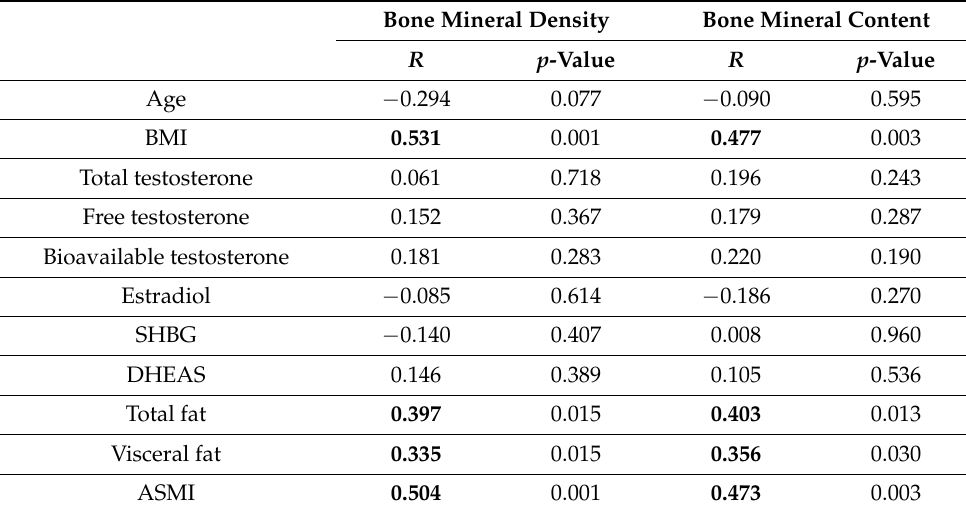
Table 4. Correlations of BMD and BMC with age, BMI, sex hormones, ASMI, and fat. Bone Mineral